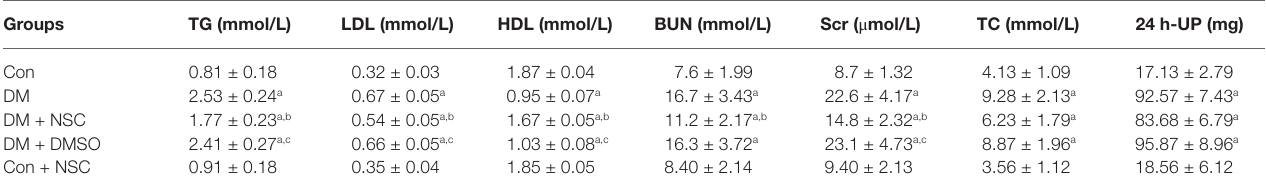
Values represent means ± SD. n = 8 in each group. a p < 0.05 vs. normal control group (Con). b p < 0.05 vs. diabetes modal group (DM). c p < 0.05 vs. inhibitor group (DM +